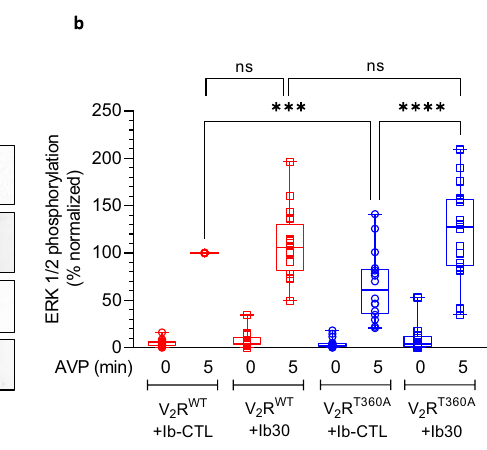
(treated as 100%) (One-way ANOVA, Sidak ’ s multiple comparisons test; *** p =0.0006, **** p <0.0001, ns=non-signi fi cant). The data represented as box plots showing median, IQR with whiskers of 1.5× IQR, and circles represent values from sixteen independent experimental replicates. Source data are provided as a Source Data fi